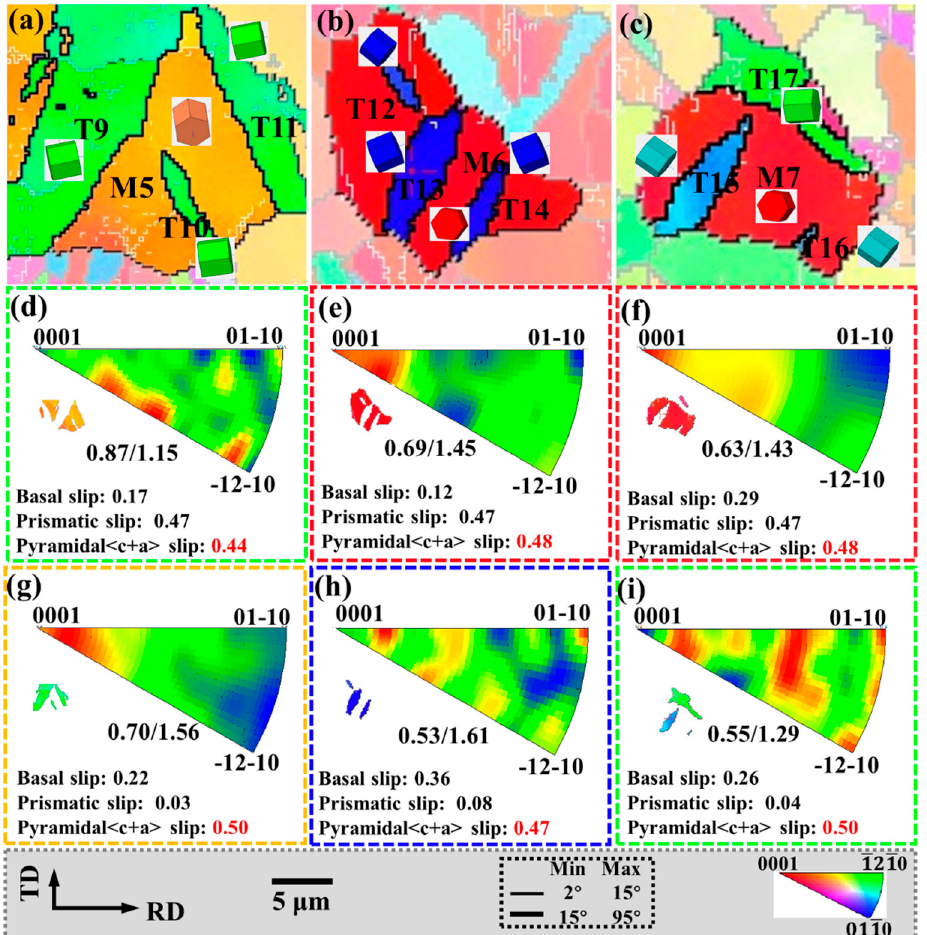
Figure 11. IGMA of non-parallel twins: ( a – c ) the IPF, ( d – f ) IGMA of the matrix, and ( g – i ) IGMA of the twins.